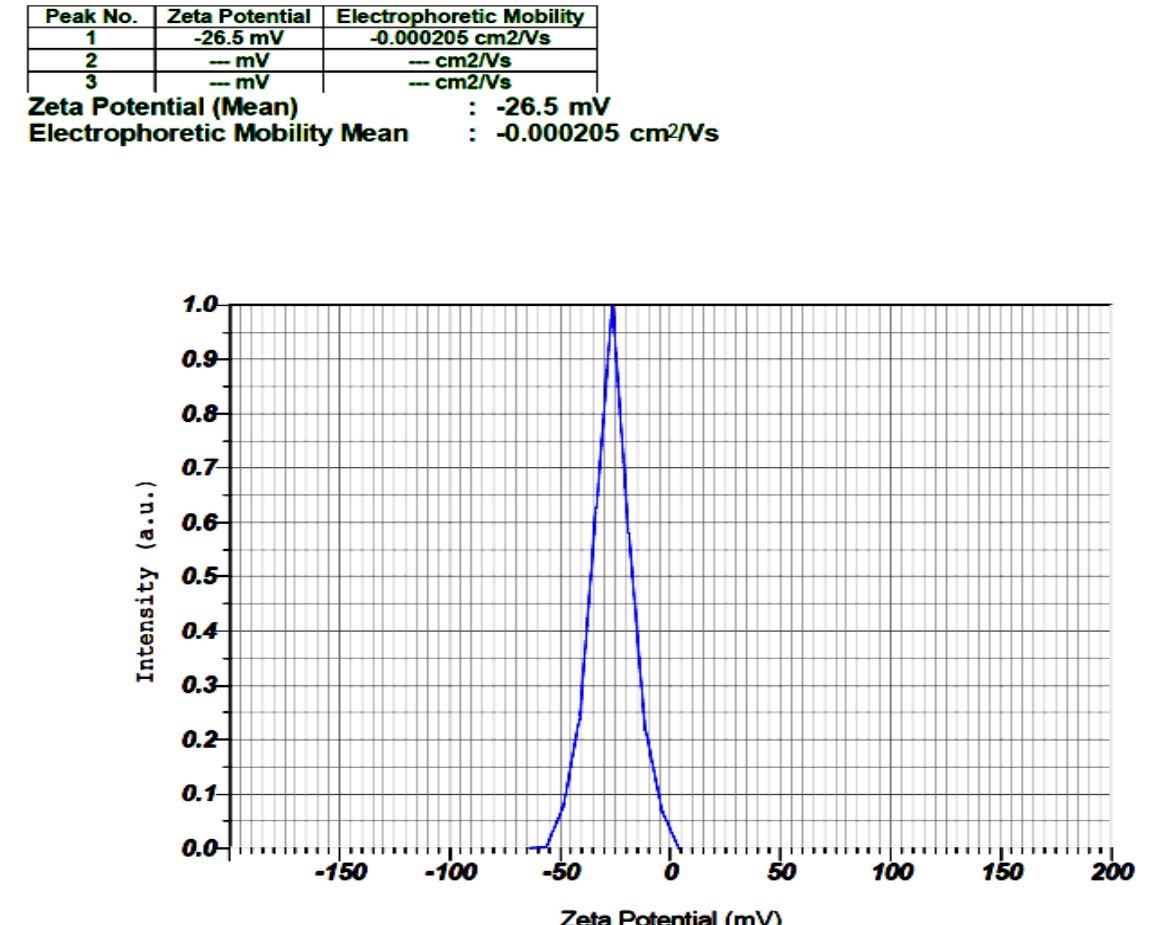
Figure 4. Zeta potential (mean) of TPE-mediated ZnO NPs. The negativity and distribution of ZP indicate relatively good stability, unaggregated NPs, and a suitable uniform distribution.